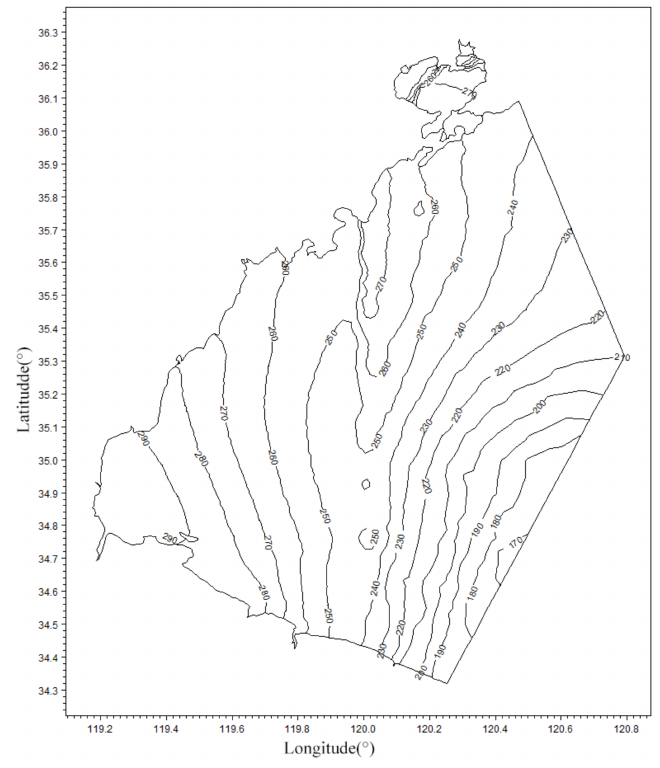
Figure 4. Continuous depth datum model (unit: cm).